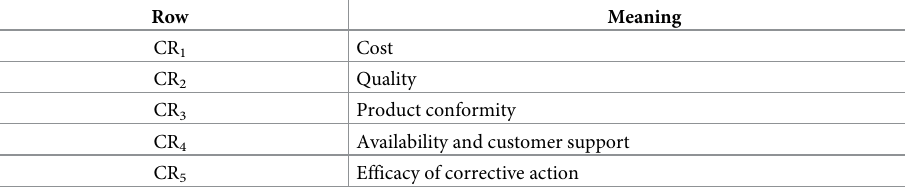
Table 2. Determined CRs for the medical products.